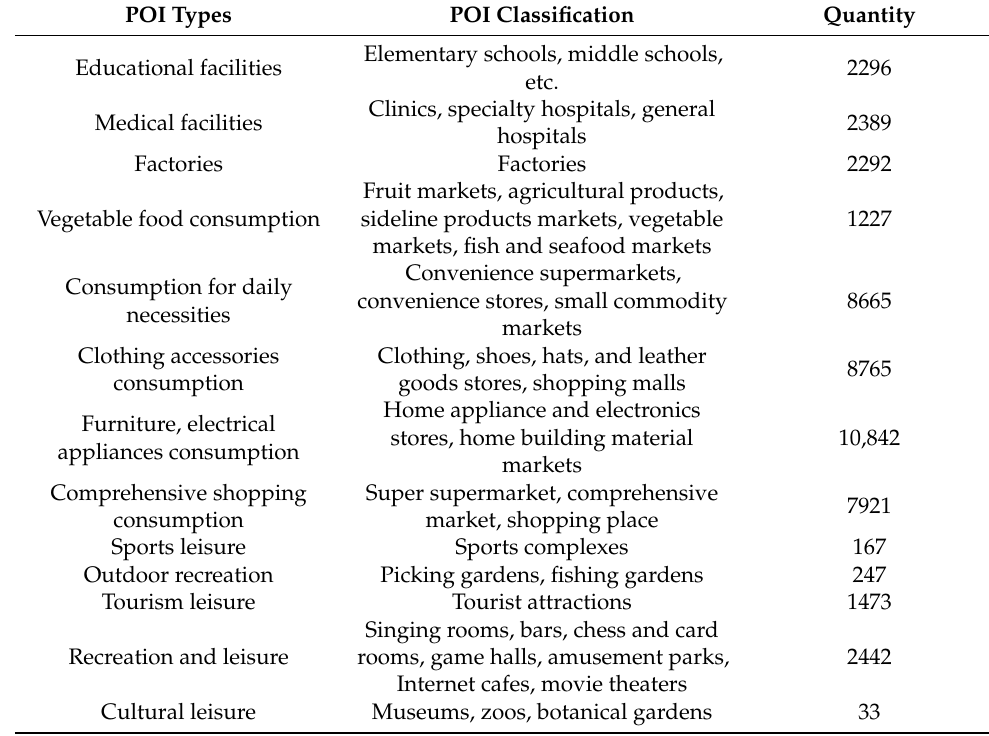
Table 1. Point of interest types and